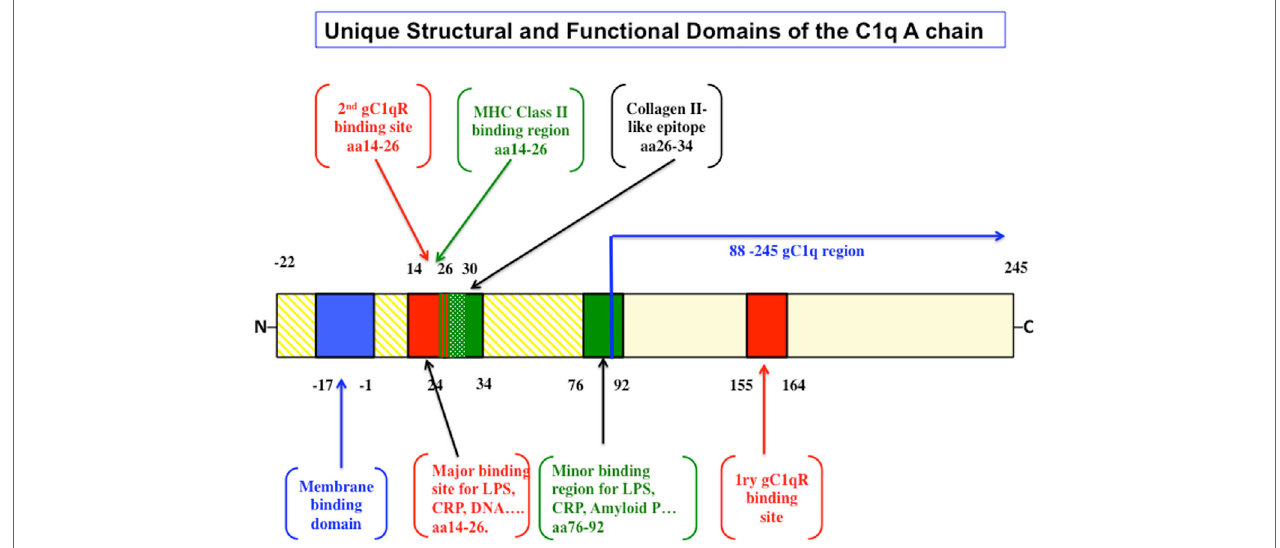
FigUre 1 | The structural and functional correlates of the C1q A-chain. The intact C1q molecule is anchored to the cell membrane by a leader peptide in the A chain. The major and minor ligand bind sites as well as the putative MHC class II binding domain are highlighted. Although the major gC1qR-binding domain spans residues 155–164, unexpected sites in the promiscuous collagen domain spanning residues 14–26 and another at 76–92 have also been shown very recently [the figure is adapted from Ref.